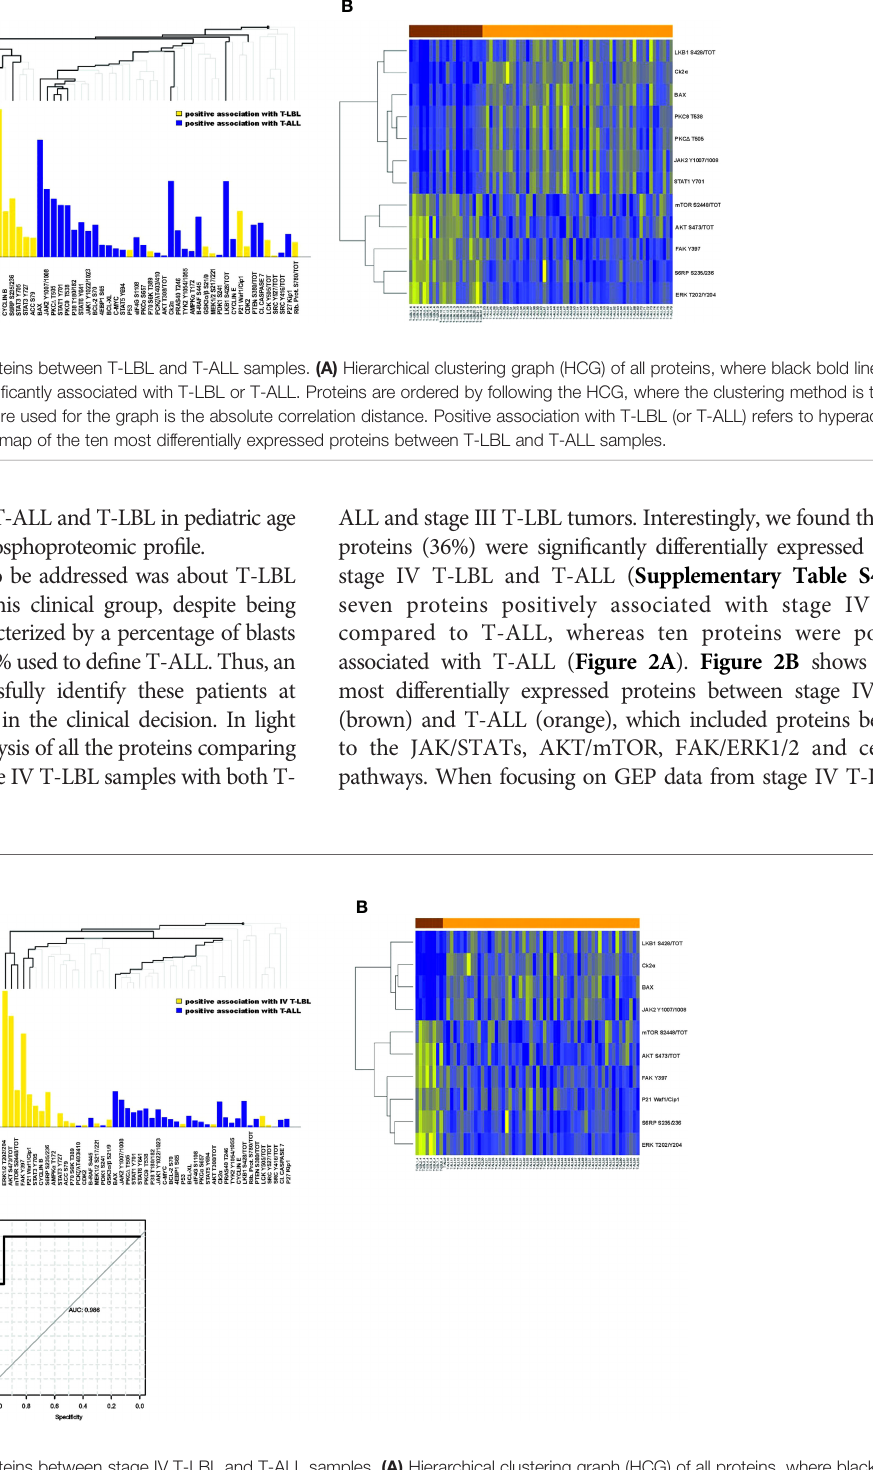
FIGURE 2 | Differentially expressed proteins between stage IV T-LBL and T-ALL samples. (A) Hierarchical clustering graph (HCG) of all proteins, where black bold lines highlight those proteins being signi fi cantly most strongly associated with stage IV T-LBL or T-ALL. Positive association with stage IV T-LBL (or T-ALL) refers to hyperactivated proteins in stage IV T-LBL (or in T-ALL). (B) Heatmap of the ten most differentially expressed proteins between stage IV T-LBL and T-ALL samples. (C) ROC curve of the predicted probabilities of being classi fi ed as a T-ALL or stage IV T-LBL for data in the testing set, together with the estimated area under the ROC curve (AUC).